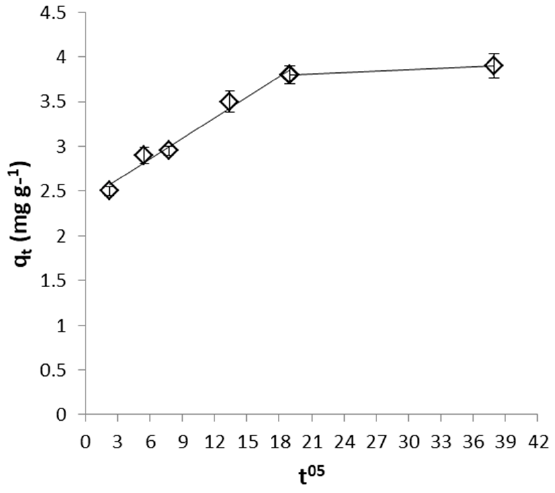
Figure 13. Weber and Morris plot for Fe II removal by WSP.